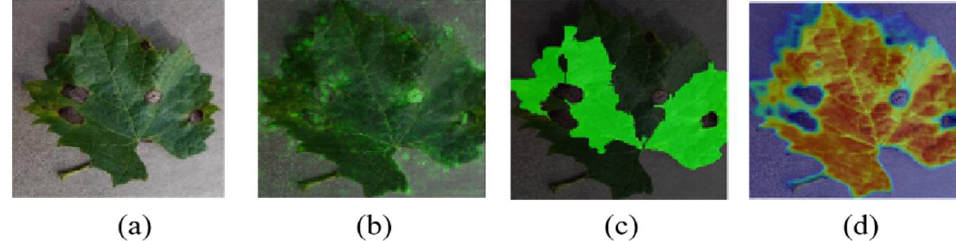
Figure 2. Schematic diagram of three visualization methods. ( a ) Original image. ( b ) Visualized schematic diagram of the SmoothGrad method. ( c ) Visualized schematic diagram of the LIME method. ( d ) Visualized schematic diagram of the GradCAM method.